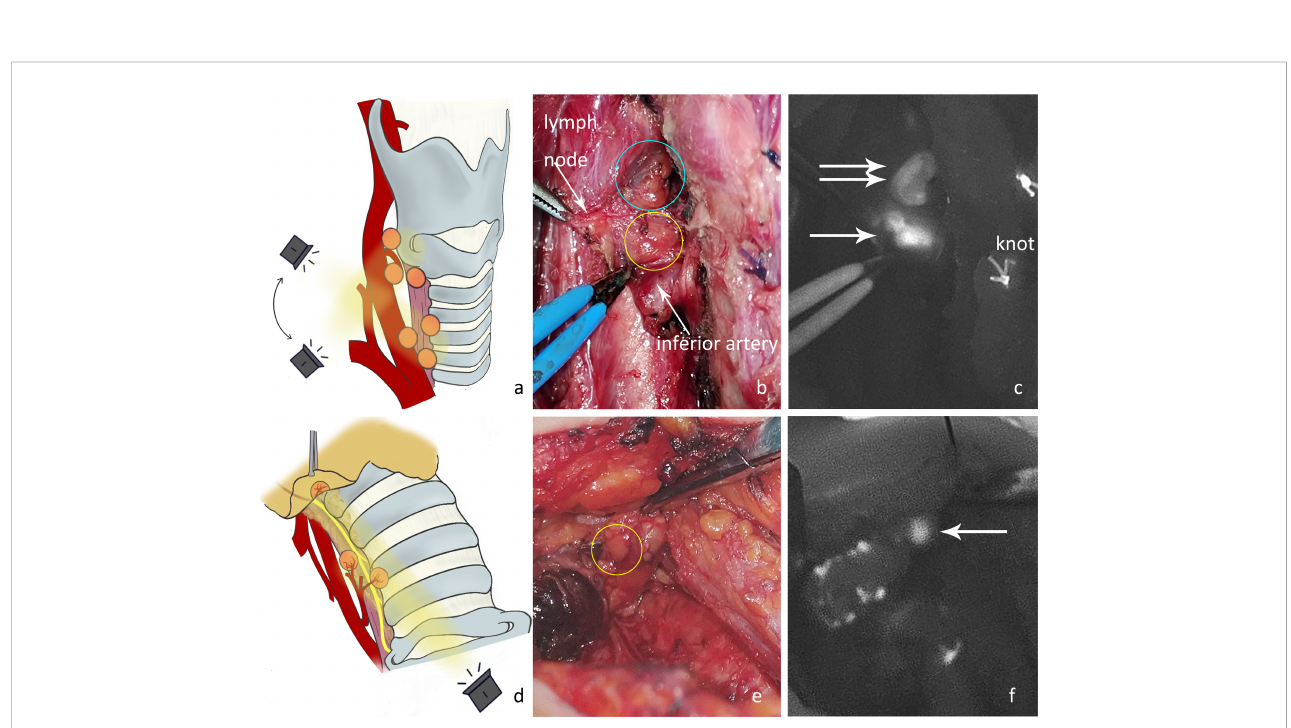
FIGURE 5 (A) Exploration of the deep surgical fi eld of the thyroid bed after thyroidectomy. (B) Under normal white light, there were two nodules between the superior parathyroid gland (blue circle) and the inferior artery in the tracheoesophageal groove. The nodule in the yellow circle was later con fi rmed by NIRAF to be the inferior parathyroid gland, and its blood supply originated from the inferior artery. (C) The NIRAF shows that the lymph node did not develop, and the type C4 gland (white arrow) was below the superior parathyroid gland (white double arrow). (D) The tissue at level VI was detected after dissociating the recurrent laryngeal nerve. (E) The type C5 gland (yellow circle) is shown under normal white light. (F) The NIRAF shows a type C5 gland (white